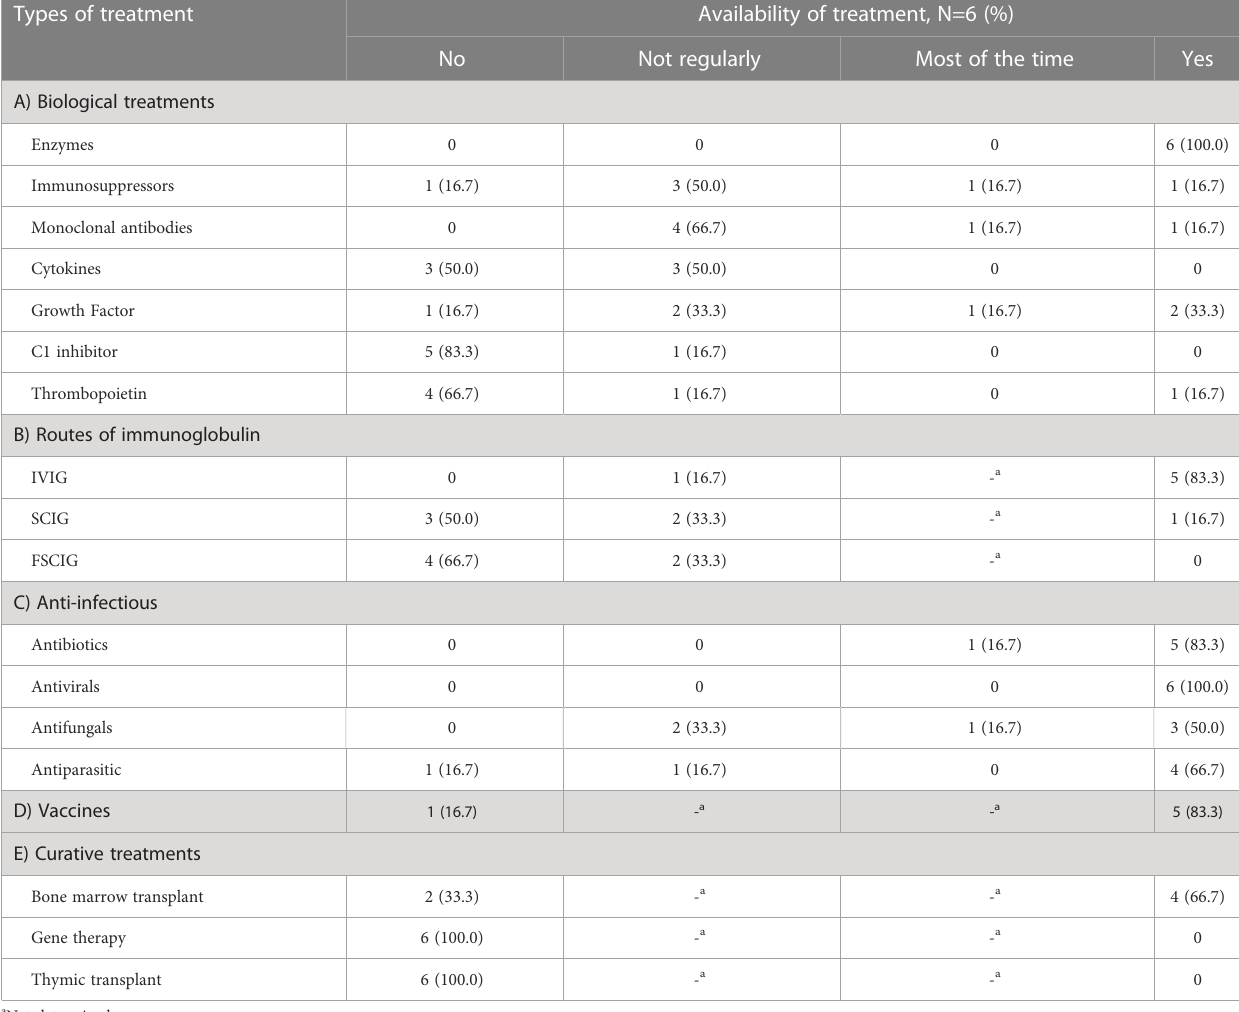
TABLE 1 Types of treatments available for Primary Immunode fi ciencies (PID) patients in Southeast Asia